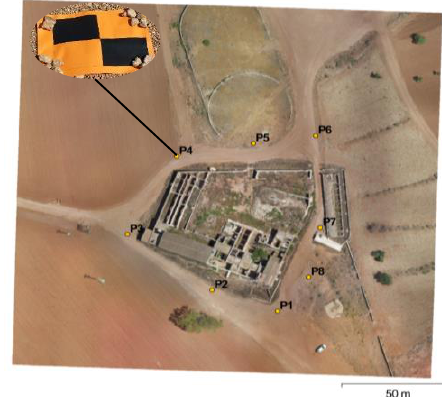
Fig. 4. Distribution of GCPs for the georeferencing of the photogrammetric project, overlapped to orthoimage obtained from photogrammetric